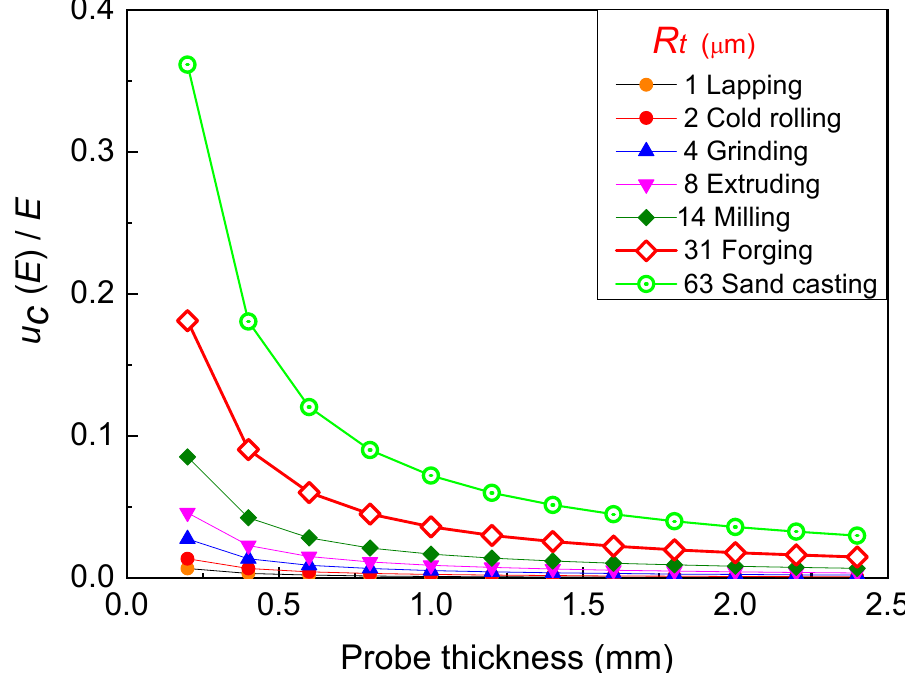
Figure 3. Trend of u c ( E ) /E vs. probe thickness h for given values of R t